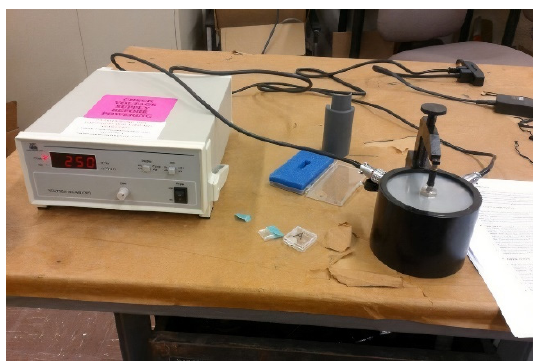
Figure 10. d 33 Meter showing calibration block force reading [14].